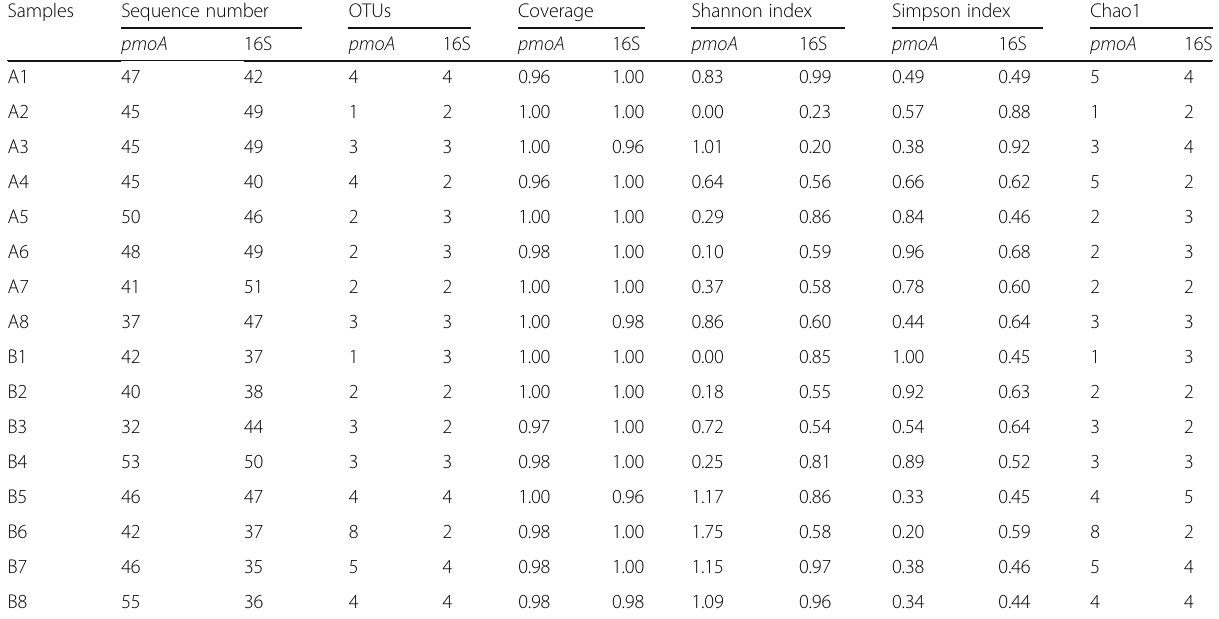
Table 2 Biodiversity of 16S rRNA and pmoA genes in Miyun Reservoir